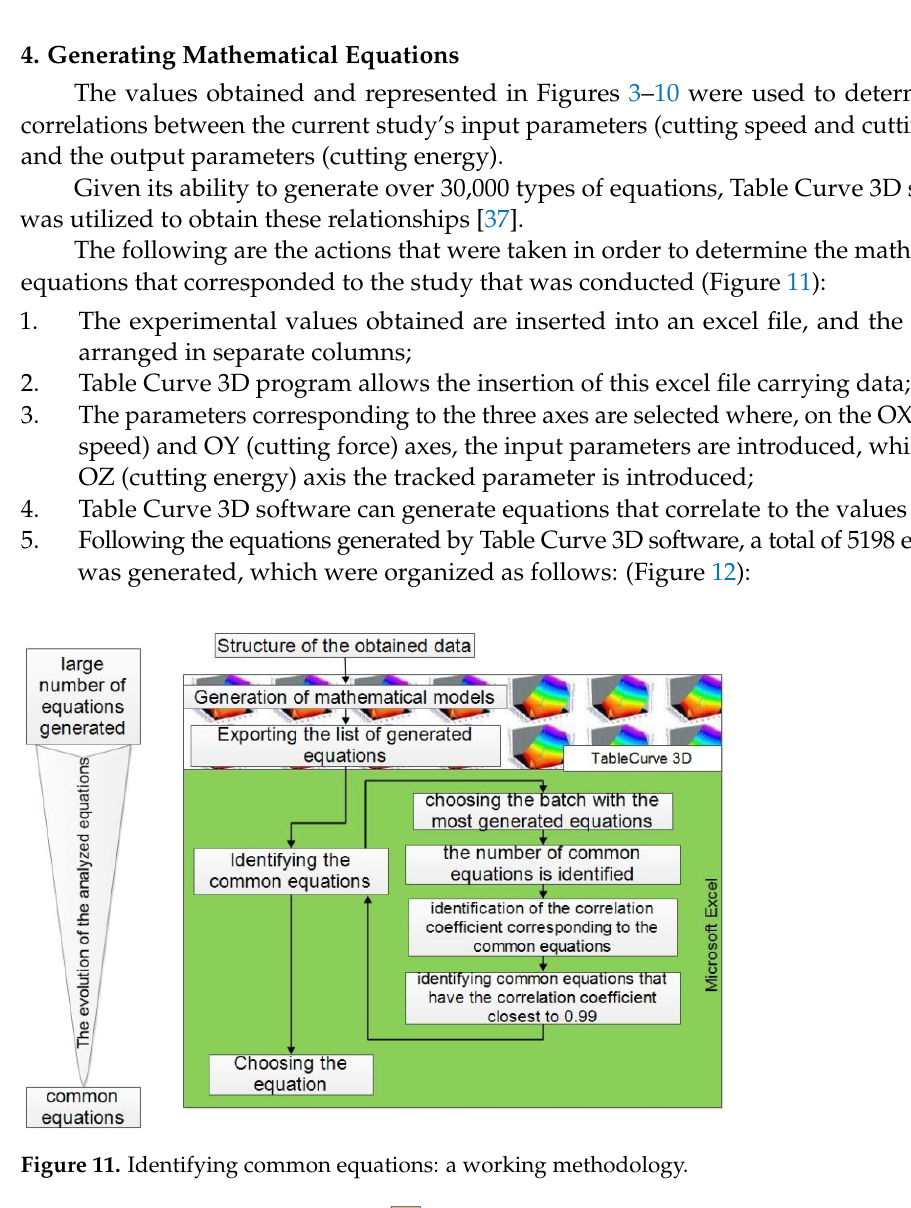
Figure 11. Identifying common equations: a working methodology.